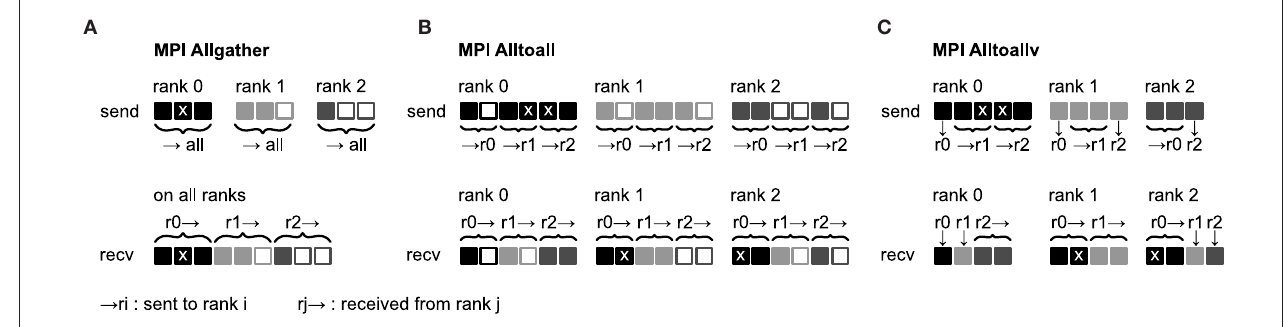
FIGURE 2 | Collective communication of receiver-selective data using MPI Allgather, MPI Alltoall, and MPI Alltoallv. The three panels illustrate send and receive buffers for the example of an MPI communication that involves three ranks. Homogeneous data types are required throughout the entire send and receive buffer. Squares represent single buffer entries. Data sent by rank 0, rank 1, and rank 2 are shown in dark gray, light gray, and medium gray, respectively. To indicate receiver selectivity, we define the data marked with “x” to be required on rank 1 and rank 2 but not on rank 0. (A) MPI Allgather: All ranks receive the entire send buffer from all ranks, which can include irrelevant data, for example, the receive buffer on rank 0 contains an “x”-entry with data that is not required. The receive buffer is a concatenation of all send buffers and the receive buffer size hence scales with the total number of ranks taking part in the communication (assuming fixed send buffer sizes). Send buffers of equal size and hence also receive buffers of equal size are required for all ranks, which can entail sending empty buffer entries (unfilled squares). (B) MPI Alltoall: Send buffers consist of equally sized sections that are destined for different receiving ranks. This allows each rank to define the data to be transmitted to any particular rank. Each rank has to send identically-sized buffer sections to each rank, which can entail sending empty buffer entries or even entirely empty buffer sections. Rank 2, for example, sends an empty buffer section to rank 1. The size of the receive buffers is identical to the size of the send buffers and independent of the number of ranks participating in the communication. To send specific data to multiple ranks, the sending rank needs to copy the data to the send-buffer sections of all intended receiving ranks, which leads to redundancy in the send buffer; rank 0, for example, sends an “x”-entry to both, rank 1 and 2. (C) MPI Alltoallv: Similar to MPI Alltoall, send buffers consist of sections that are destined for different receiving ranks. However, the sections are allowed to differ in size avoiding empty buffer entries. Adapted from Jordan et al. (2018) under CC BY 4.0 (http://creativecommons.org/licenses/by/4.0/).